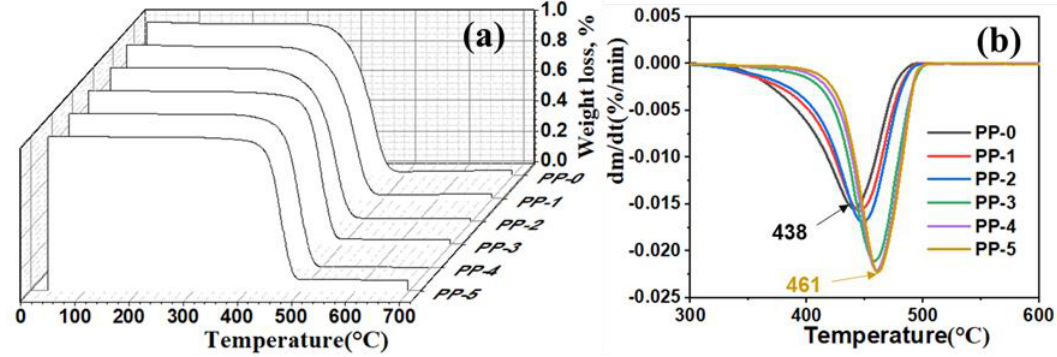
Figure 7. ( a ) Thermogravimetry (TG) traces of as-spun fibers and ( b ) differential TG (DTG) spectra.